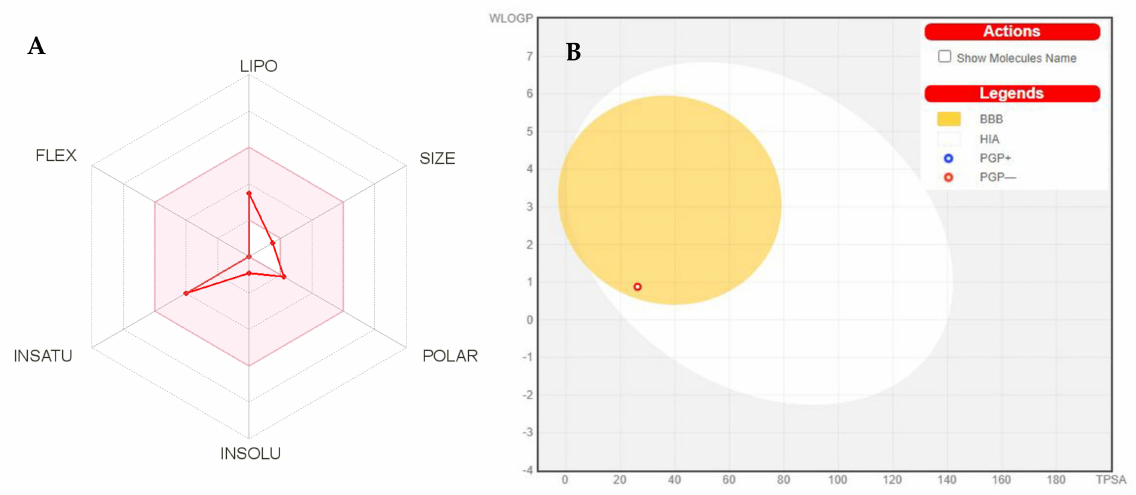
Figure 8. ( A ) . Bioavailability radar chart for MVL. The pink zone represents the physicochemical space for oral bioavailability, and the red line represents the oral bioavailability properties. ( B ) Predicted BOILED-Egg plot from swiss ADME online web tool for